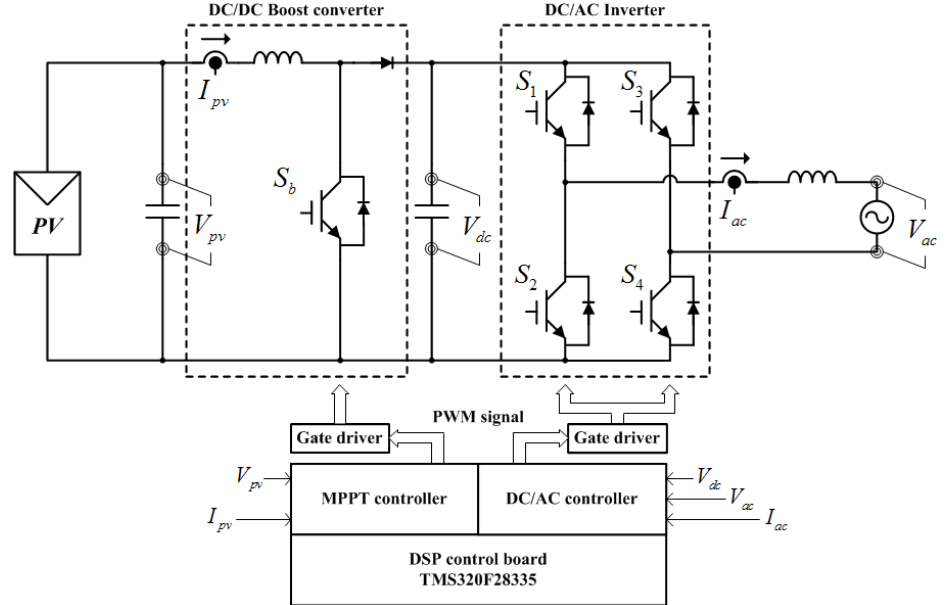
Figure 1. Diagram of a two-stage single-phase PV PCS.